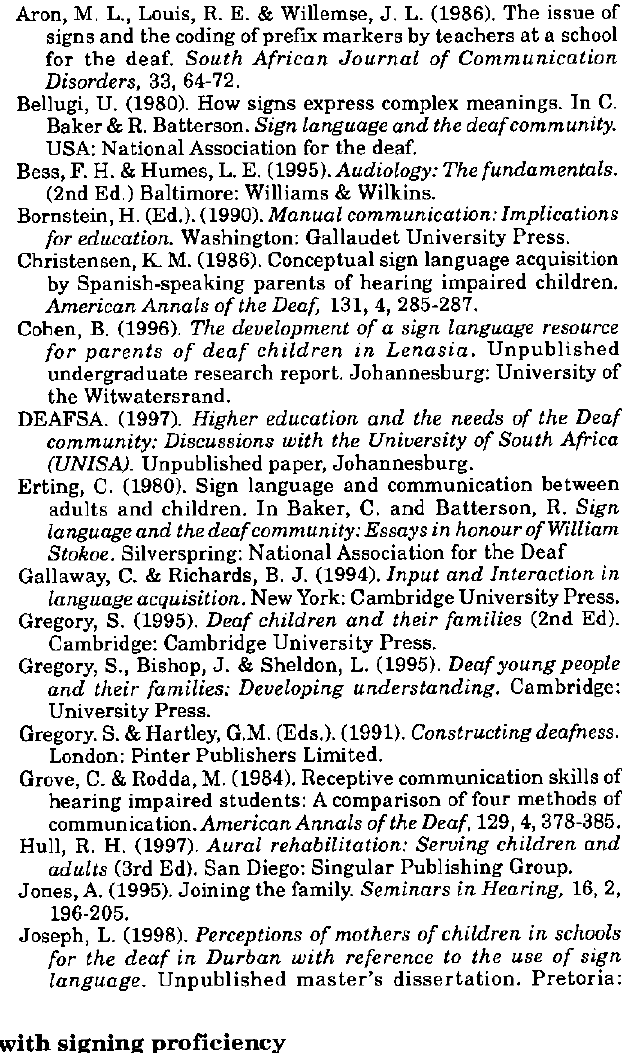
TABLE 5: Exploration of selected variables associated with signing proficiency